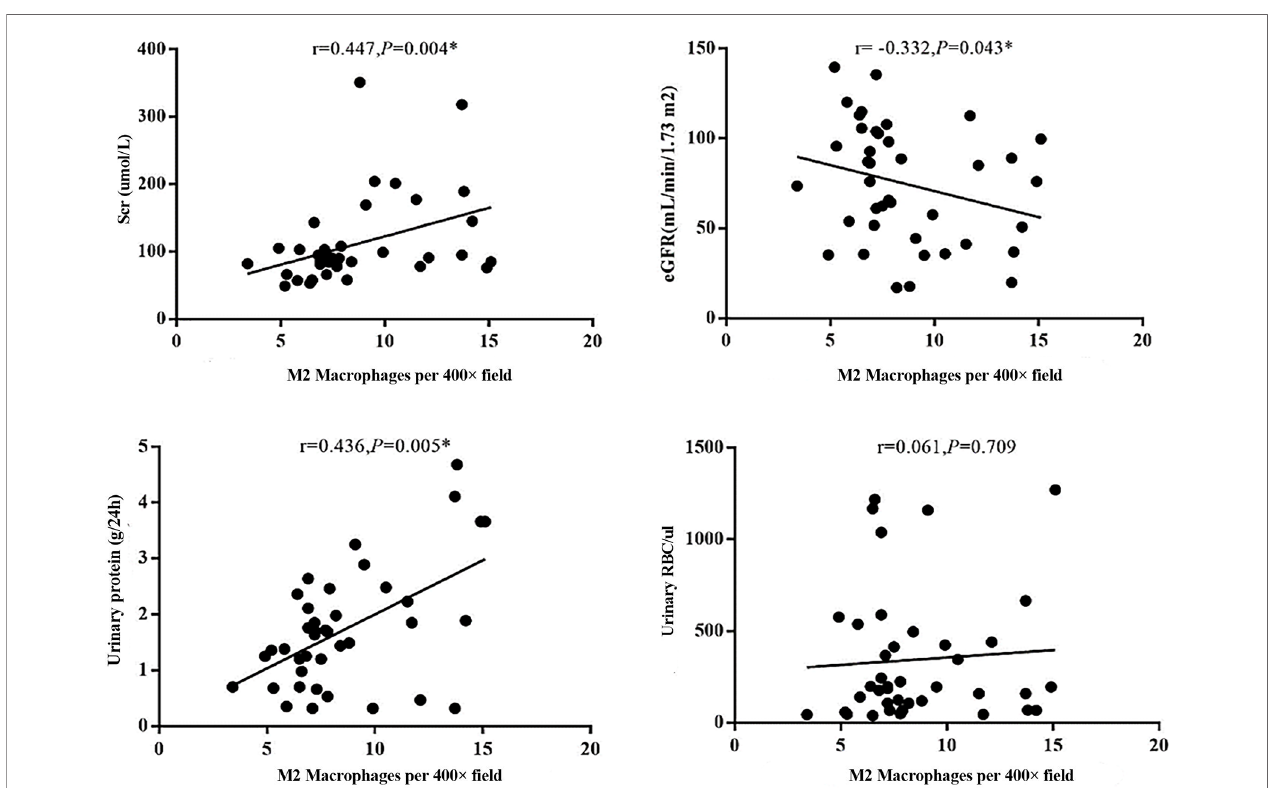
FIGURE 6 | Different types of macrophages and clinical manifestation of IgAN. The number of M2 macrophage in fi ltration was positively correlated with serum creatinine and 24-hour proteinuria (r=0.447, P=0.004; r=0.436, P=0.005), and negative correlated with eGFR (r=-0.332,